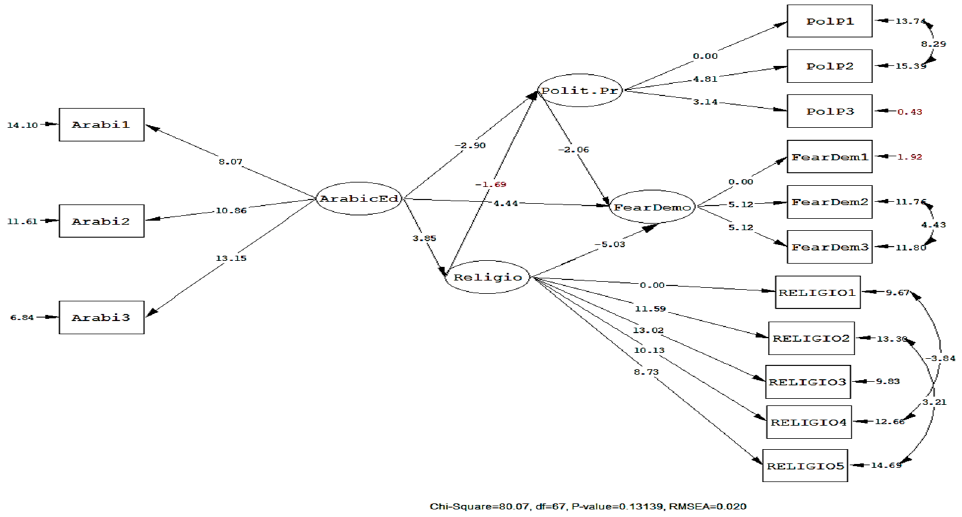
Figure 2. The t -value of the model (Source: Lisrel output).